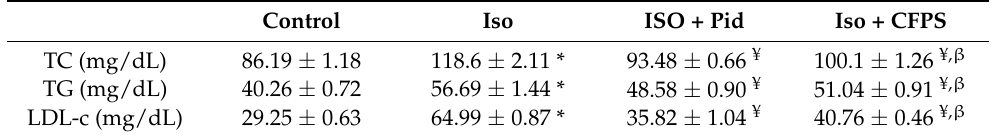
Table 5. Effect of CFPS fraction on lipidic profile.